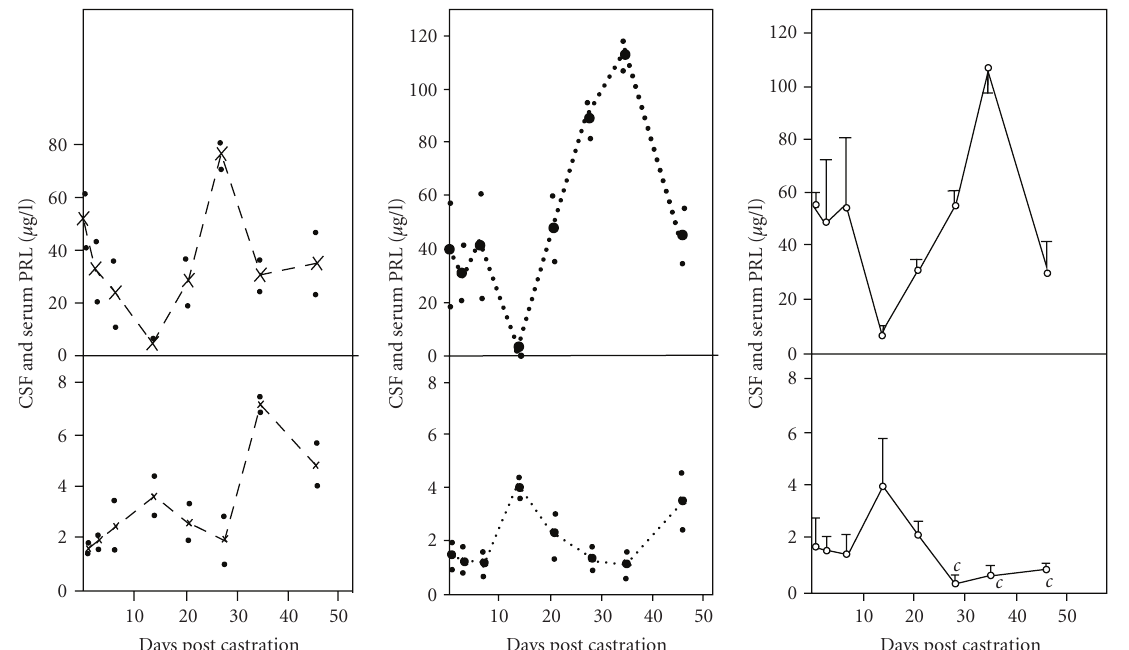
Figure 7: Comparative levels of PRL in the serum and CSF of male rats at di ff erent days following castration. Upper panels. Serum PRL levels. Lower panels. CSF PRL levels. Values are expressed in terms of NIADDK-rat-PRL-RP-3. “ c ” denotes significant di ff erence at P < . 05 level with respect to intact controls. Solid line with open circle (- ◦ -), dashed line with cross (– × –), and dotted line with closed circle ( ···•··· ) represent data from castrated, intact, and sham operated rats, respectively. At each day of castration, values are expressed as mean ± SEM of three or more determinations in duplicate of serum/CSF samples. In intact and sham-operated controls, each value is a mean of two determinants in duplicate of serum/CSF. Small dots ( • ) denote value of each determination. Vertical bars represent SEM. Prolactin was estimated by RIA in serum and CSF of normal and 1–46 day castrated rats [66]. Table 4: E ff ects of fluphenazine decanoate on fertility parameters and serum hormones in adult male rat. A ff ected parameters